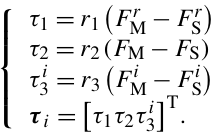
Where i = a,b , a and b represent gripper A and gripper B